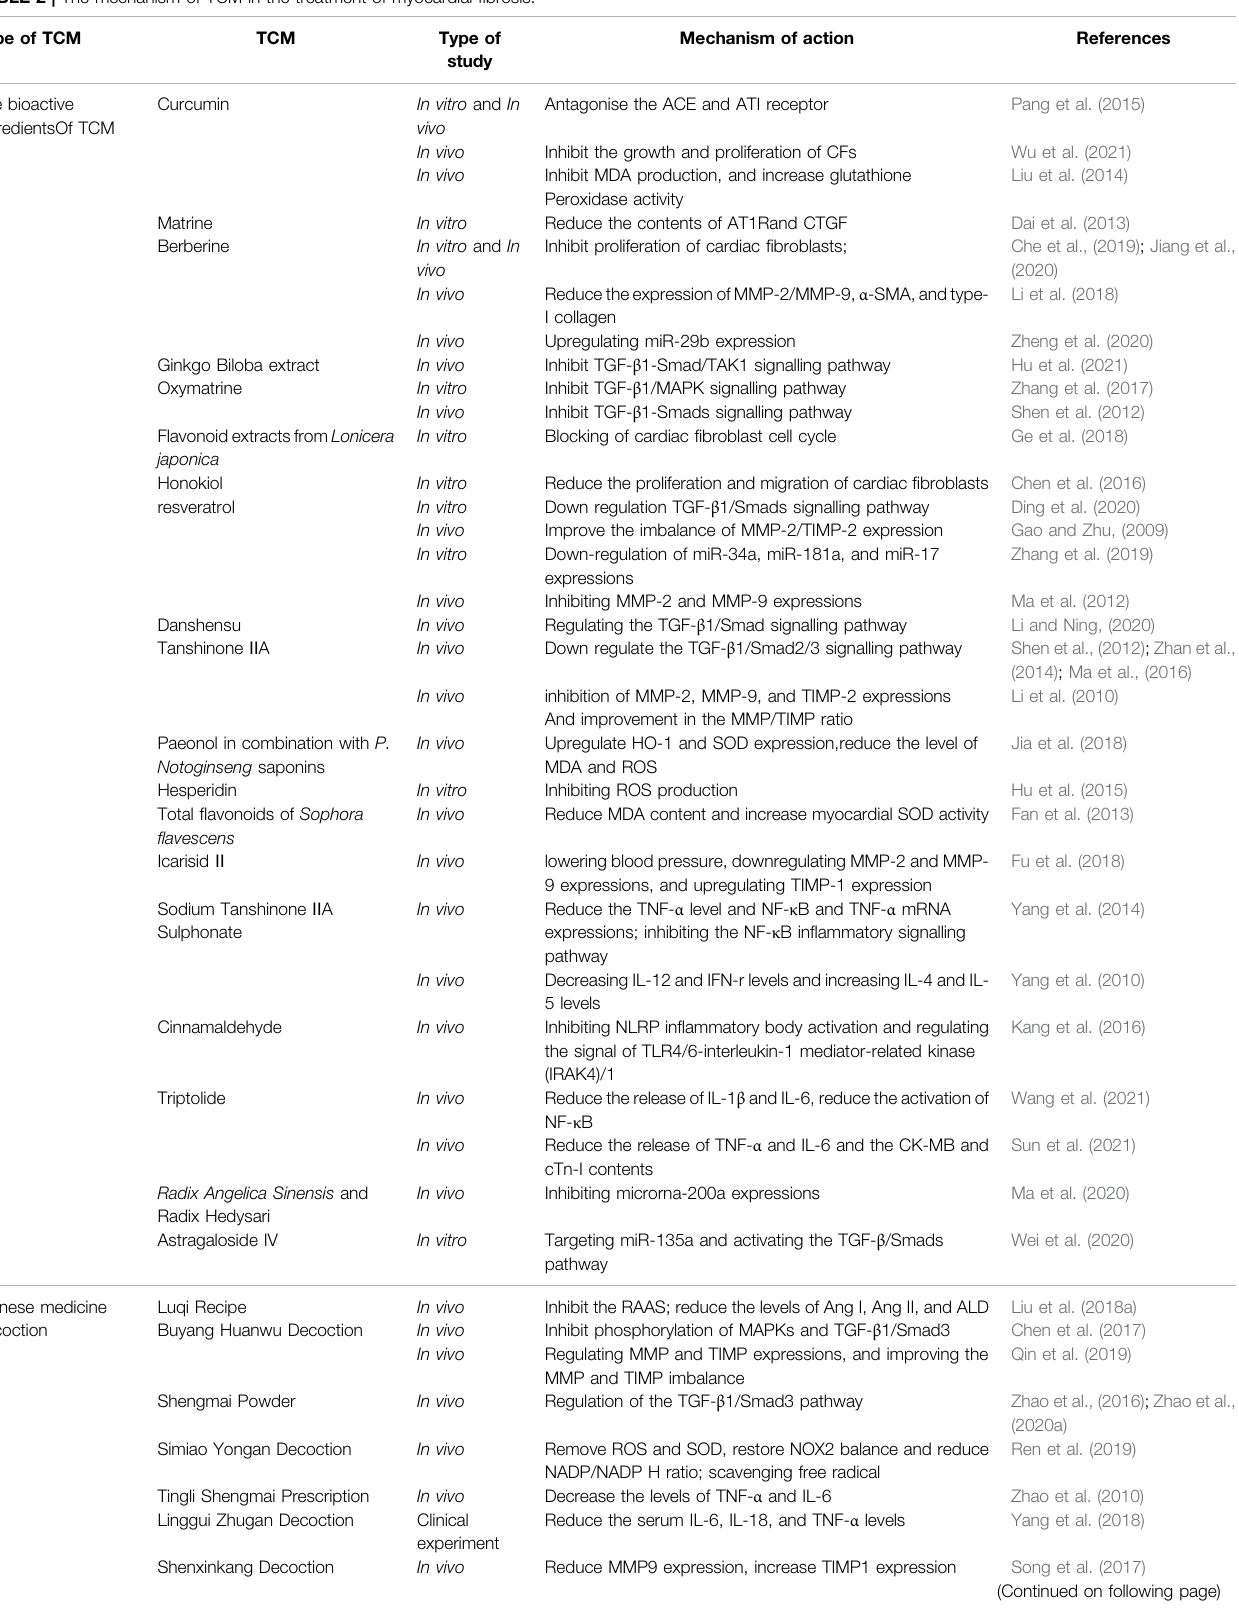
TABLE 2 | The mechanism of TCM in the treatment of myocardial fi